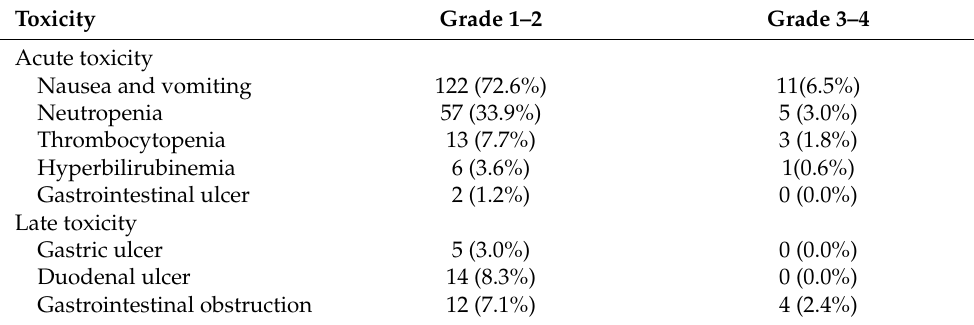
Table 3. Treatment-related Toxicities.